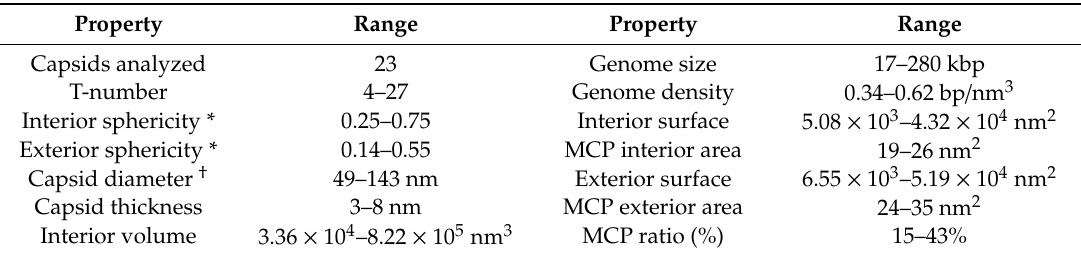
Table 1. Summary of measured structural properties. * The sphere factor ranged from 0 (polyhedral)